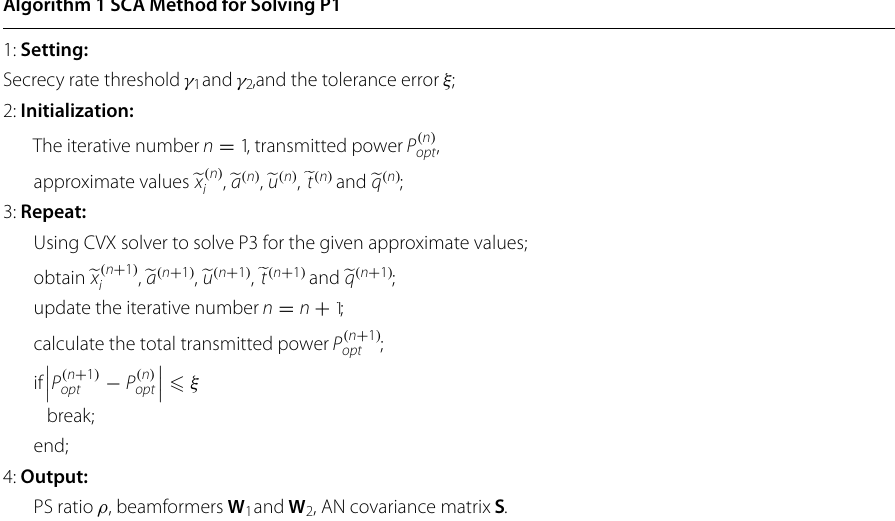
Table 1 The SCA-based algorithm Algorithm 1 SCA Method for Solving P1